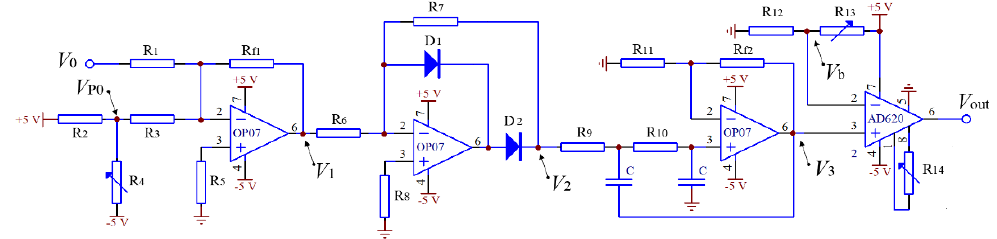
Figure 8. Signal process circuit.